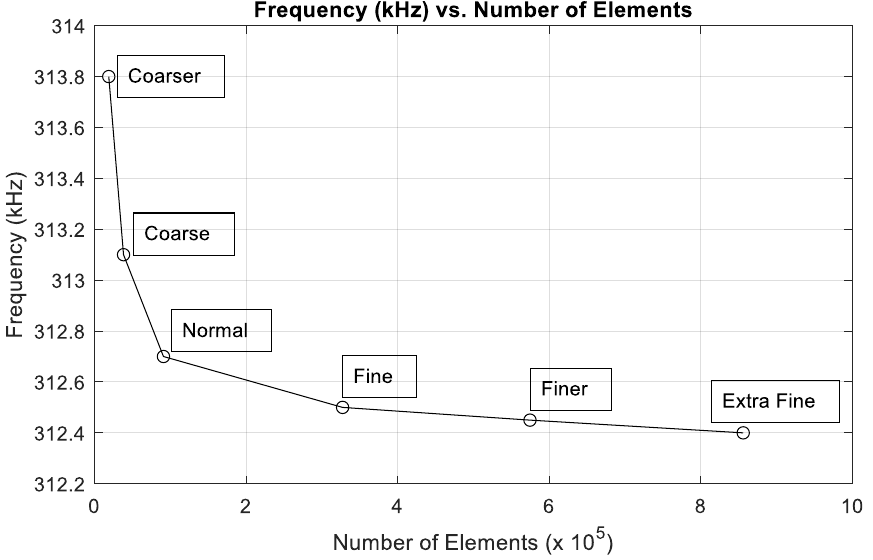
Figure 2. Mesh refinement study for microcantilever, microbridge, and clamped membrane struc- tures.